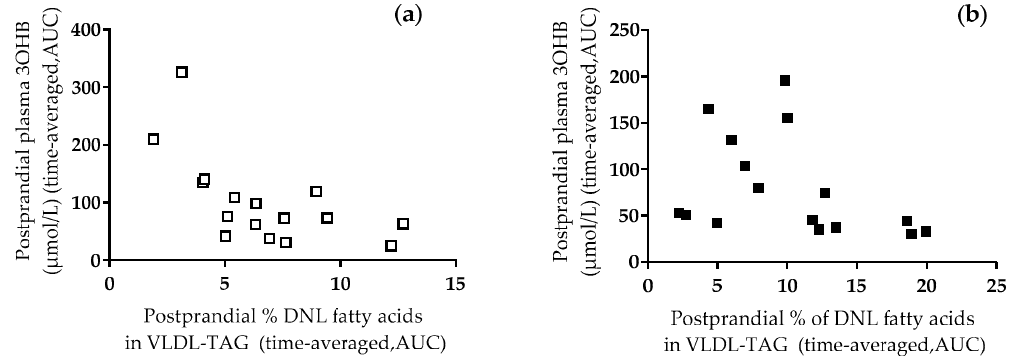
Figure 3. The association between the postprandial contribution (%) of DNL fatty acids in VLDL-TAG and the postprandial plasma concentrations of 3-hydroxybutyrate (3-OHB) after ( a ) the low fructose meal, and ( b ) the high fructose meal.